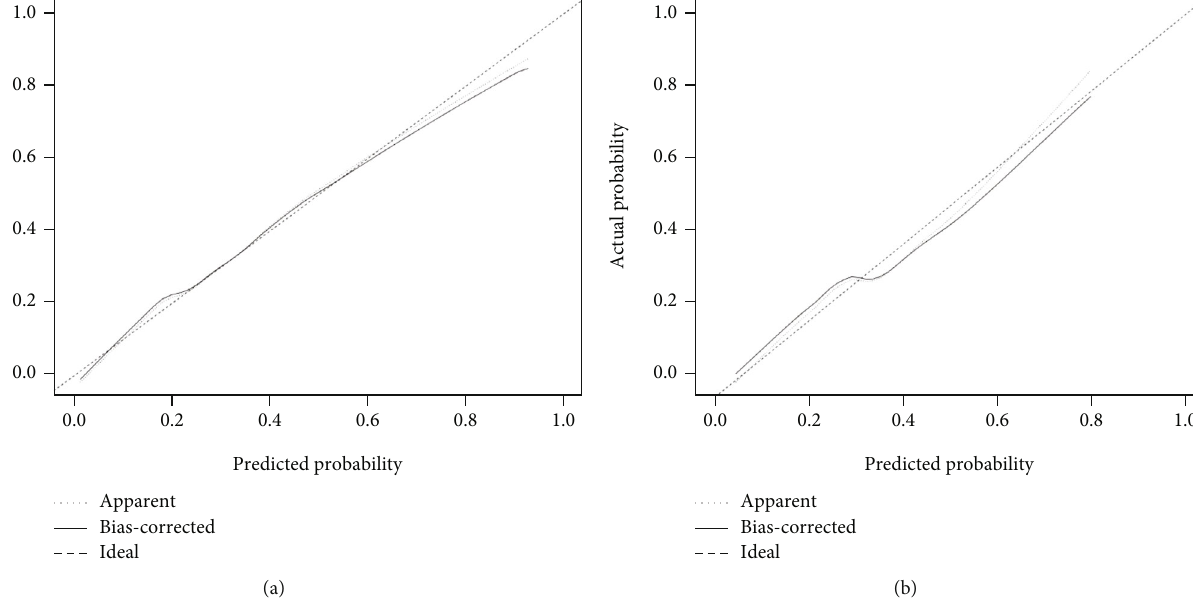
Figure 4: Calibration curve of the nomogram on the data of training set (4A) and validation set